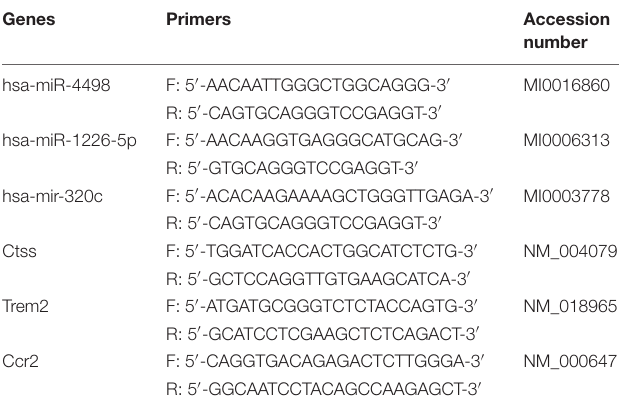
TABLE 2 | Primers for reverse transcription-polymerase chain